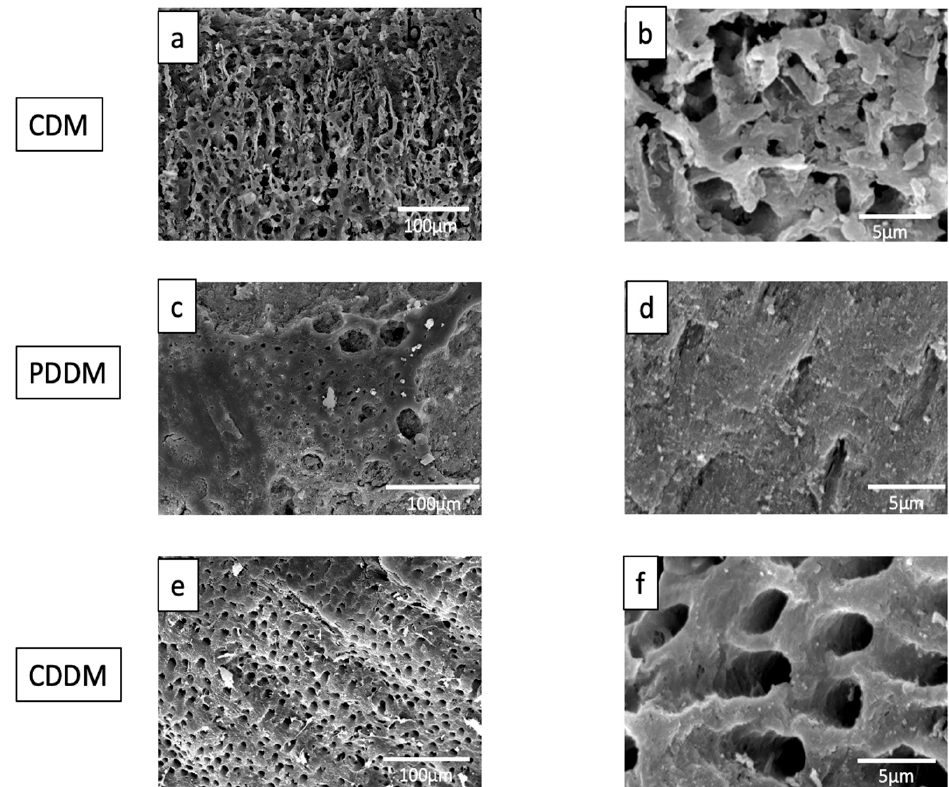
Figure 6. SEM photographs of CDM, CDDM and PDDM after collagenase digestion for 12 weeks. ( a , b ) CDM: Trabecular and irregular structure. ( c ) PDDM: Various crater-like round spaces. ( d ) PDDM: dentinal tube-spaces with scale-like surface. ( e , f ) CDDM: Uneven surface with wide dentinal tube spaces and irregular bulk matrix. CDM: Calcified dentin matrix, PDDM: Partially demineralized dentin matrix, CDDM: Completely demineralized dentin matrix.